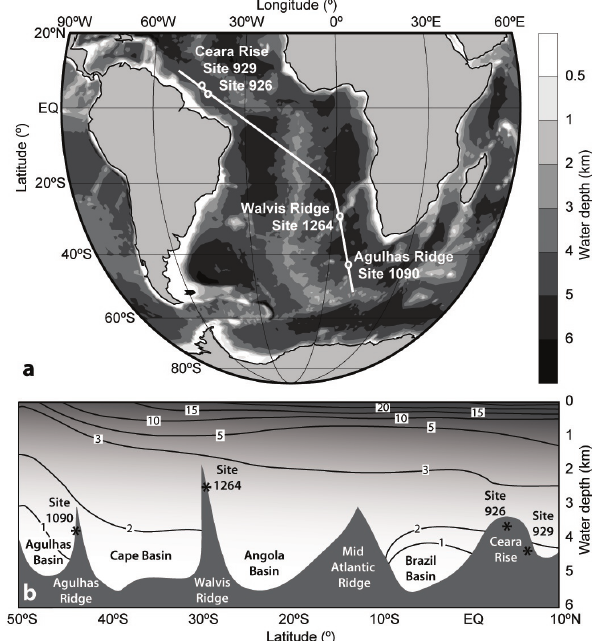
Fig. 1. Site locations and Atlantic Ocean transect. (a) Present day map of the drill locations of ODP Sites 929, 926, 1264 and 1090. The white line through the drill locations represents the approxi- mate transect shown in panel (b). (b) Transect through the current Equatorial and Southern Atlantic Ocean. Black stars represent drill locations. Black lines represent present-day water temperatures. Both graphs were constructed using Ocean Data View (Schlitzer, 2010) and were then graphically